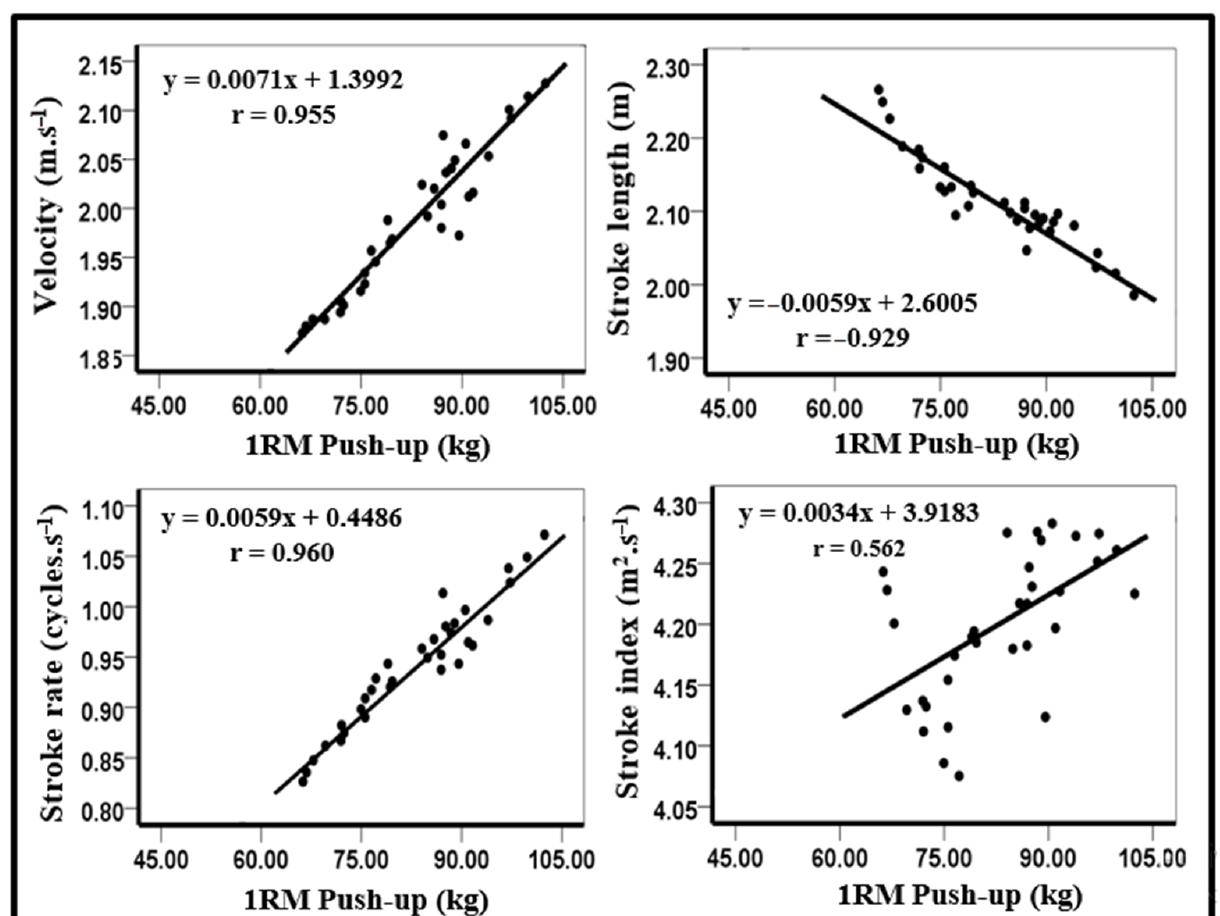
Figure 4. Relationship between kinematical variables and the calculated predicted 1-RM push-up.